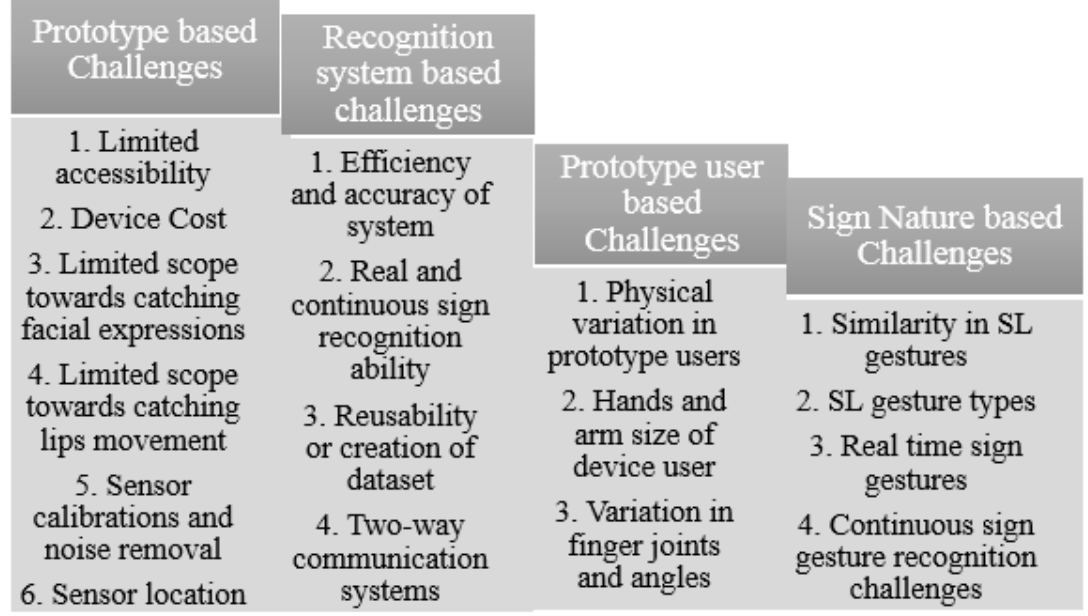
Figure 21. Recommendation perspective of sign language. 9.1. Developers